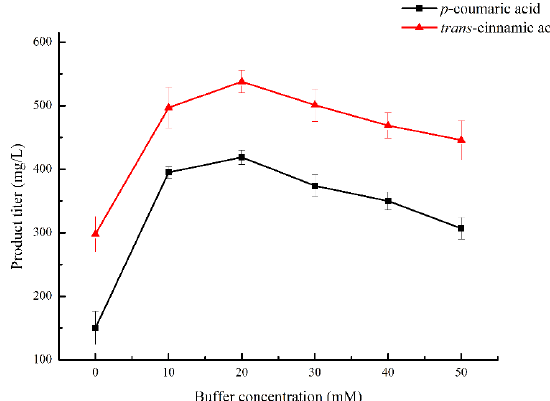
Figure 5. Effect of buffer concentration on conversion of L-Phe and L-Tyr to trans -cinnamic acid and p -coumaric acid by E. coli BL21(DE3)/pETDuet-1- RgPAL . Reaction conditions: Temperature: 42 °C; Medium: pH 9.0 Glycine-NaOH; L-Phe and L-Tyr 1 mg/mL; L-Phe conversion time: 24 h and L-Tyr conversion time: 20 h; Cell amounts: 6.67 g/L.